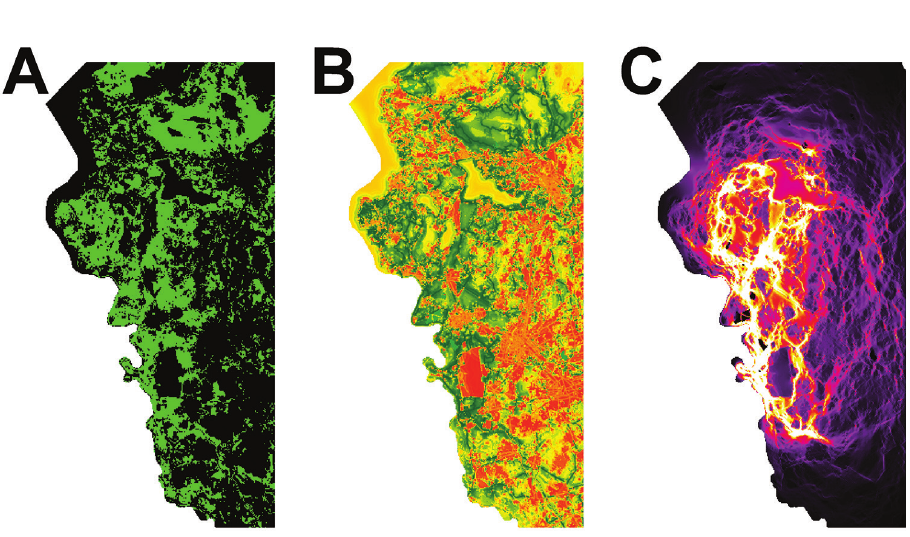
Figure 2. a Suitability areas for the stag beetle derived by the Ensemble of Small Models (green and black areas indicate suitable and unsuitable areas, respectively) b Resistance surface for the stag beetle (green- red scale indicates lower-higher resistances, respectively) derived by the Ensemble of Small Models, ESMs (1- probability of occurrence) c current map for the stag beetle (black-yellow scale indicates lower-higher connectivity, respectively) derived from resistance surface using Circuitscape